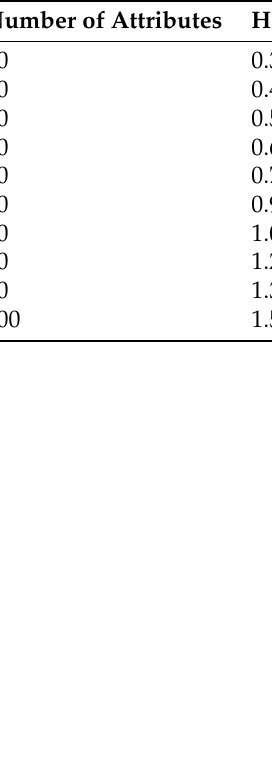
Figure 8. Encipher time in data owner part. Table 4. Execution time of the data owner.